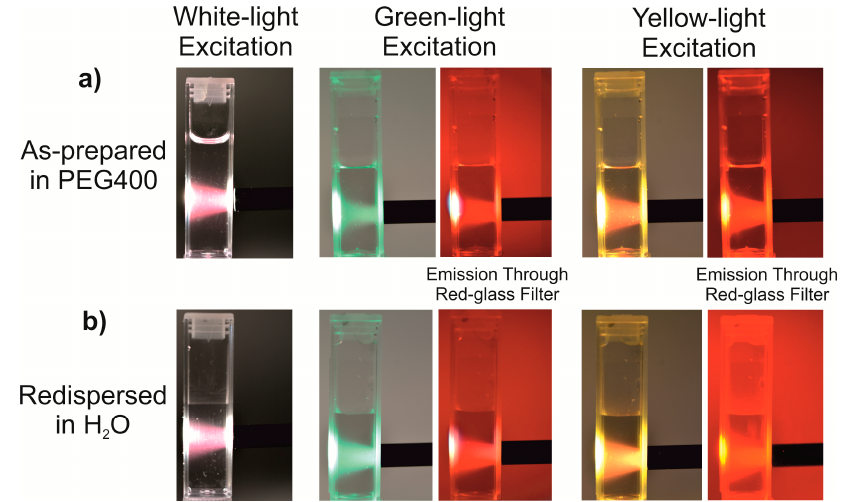
Figure 8. Photos showing the red emission of the as-prepared C-dots in ( a ) PEG400 and ( b ) H 2 O upon